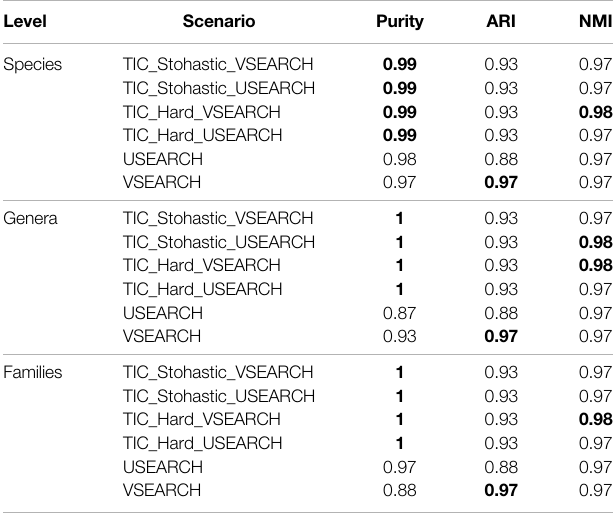
TABLE 1 | Clustering quality comparison among